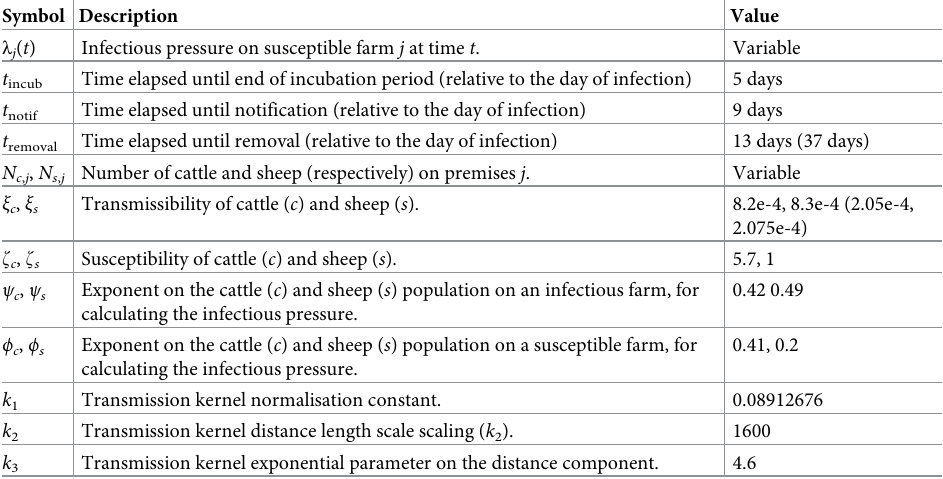
Table 1. Summary of parameter notation and descriptions. All values are for the default pathogen characteristics, except those stated within parentheses that correspond to the alternate pathogen. Symbol